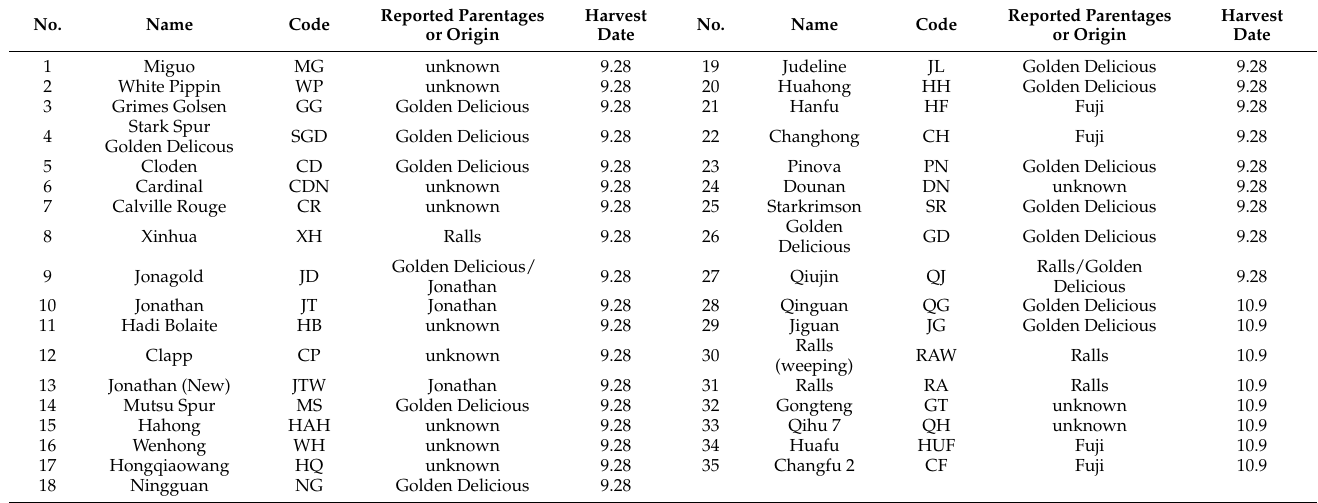
Table 1. 35 apple varieties